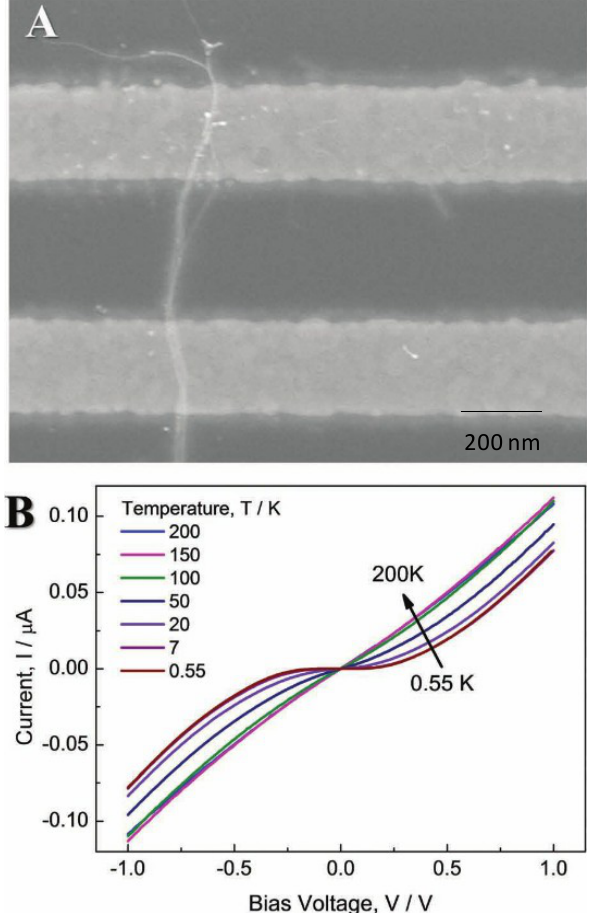
Figure 1. ( A ) SEM image of a rope of Au nanowires crossing an array of Au electrodes; ( B ) current versus voltage behavior of Au NW in different ranges of temperatures.